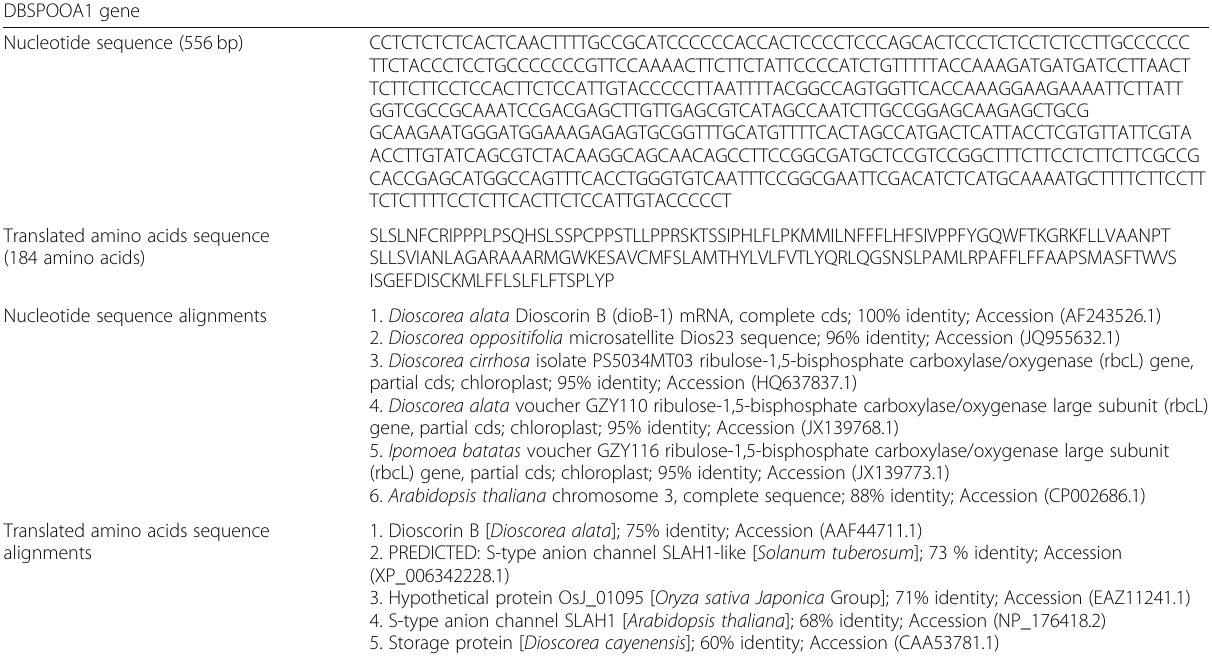
Table 2 Dioscorin gene DNA marker (DBSPOOA1-556) nucleotide sequence and deduced amino acid sequence alignments and homologous